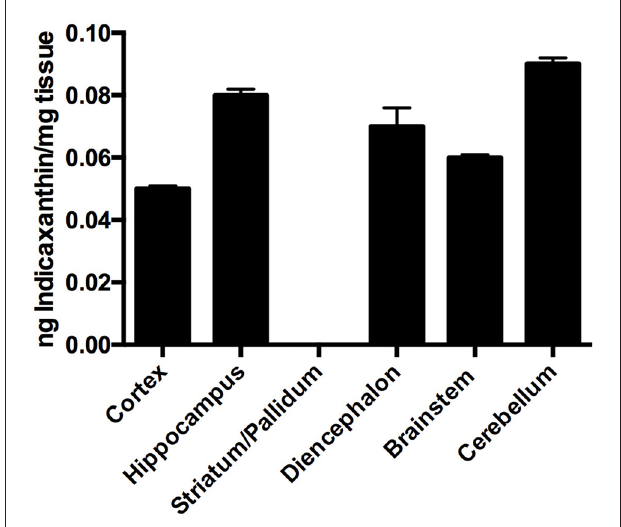
FIGURE 2 | Distribution of indicaxanthin in selected rat brain areas 60 min after ingestion of 2 µ mol/kg, expressed as ng/mg tissue. Values are indicated as means ±